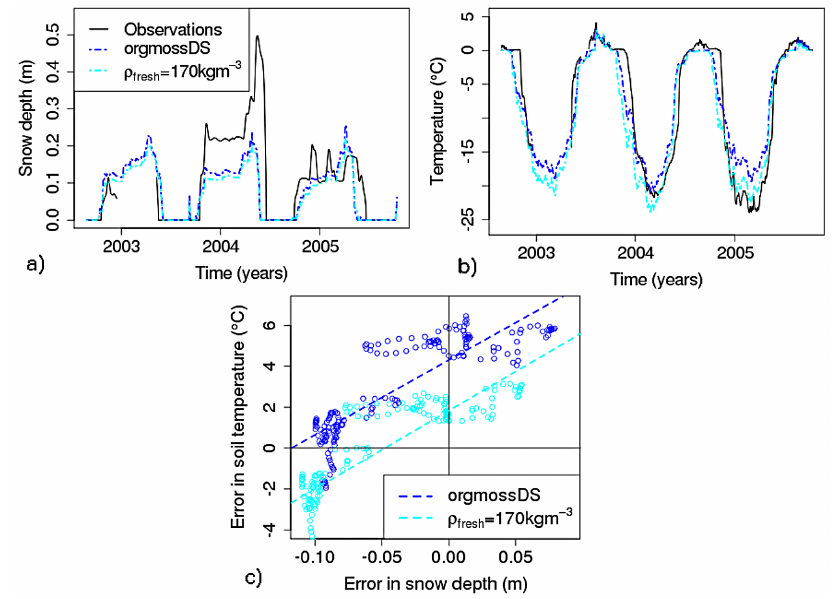
Figure 8. Effect of increasing the fresh snow density ( ρ fresh ) from 130 to 170kgm − 3 for the simulation set-up orgmossDS (Table 1). The lower plot compares the error in soil temperatures and snow depths for the coldest months only (January–March) using daily values.